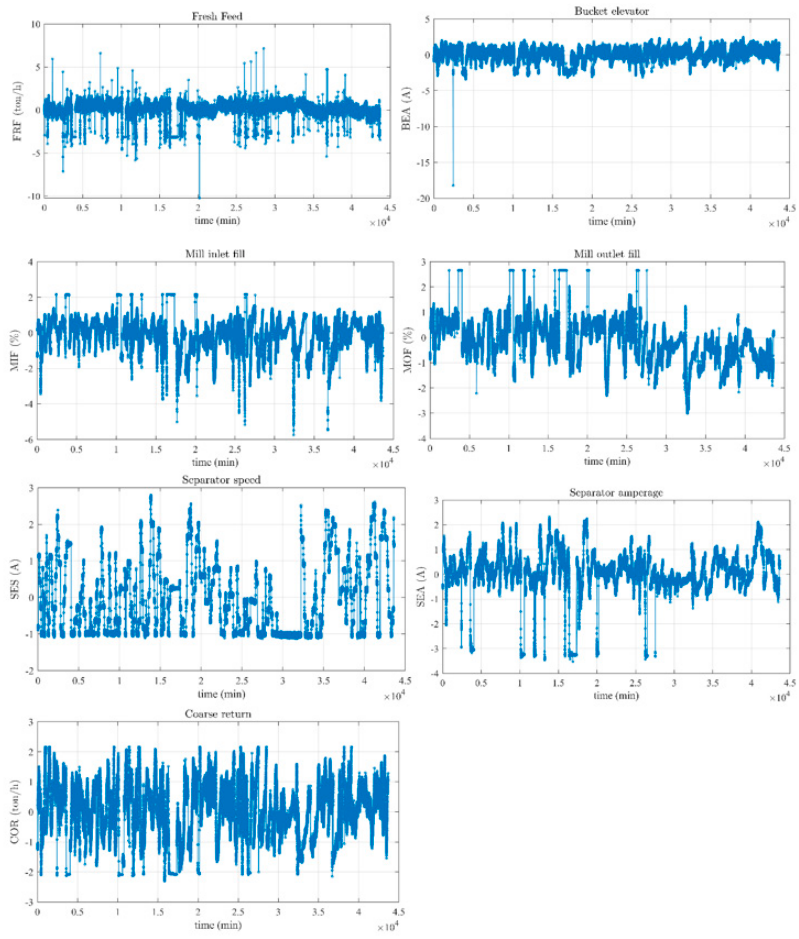
Figure 3. Collected input and output samples over 43,000 min. A schematic of the shortlisted mill and separator parameters, including the coarse return feedback loop as presented in Figure 4.